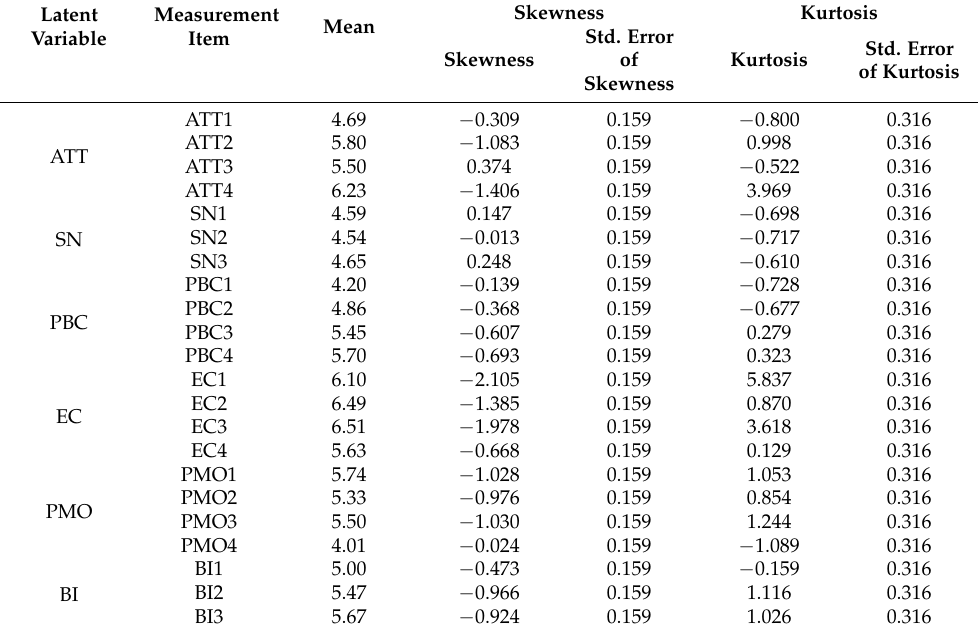
Table 3. Skewness and kurtosis.